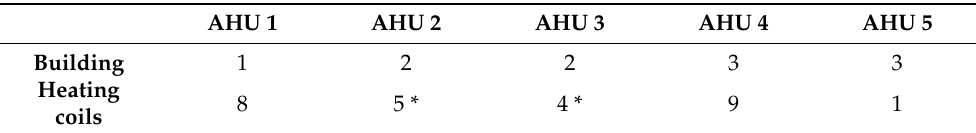
Figure 5. Simplified schematic of heating distribution system of one AHU. Table 1. Heating coils of each AHU per building.